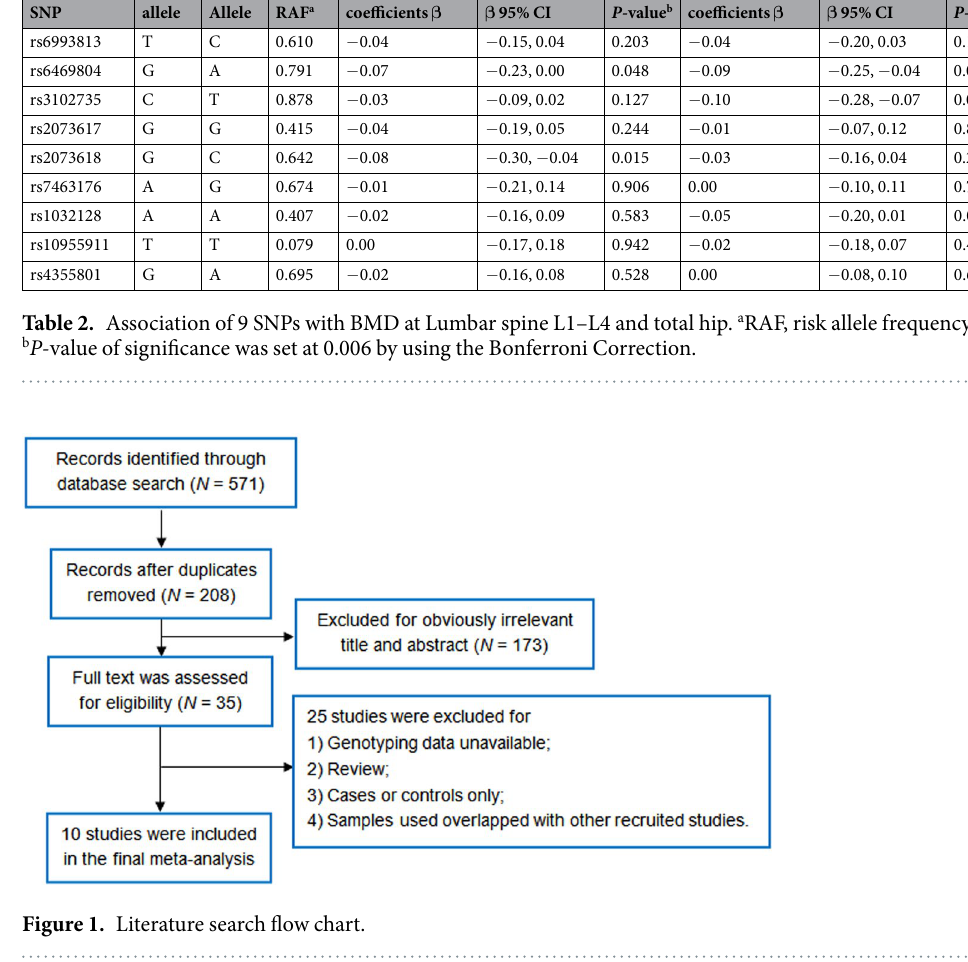
Table 1. The observed allelic frequency distributions in controls for all SNPs analyzed were in Hardy–Weinberg equilibrium ( P > 0.05). Meanwhile, based on the following assumptions: P = 0.05, OR = 2.00 corresponding to a